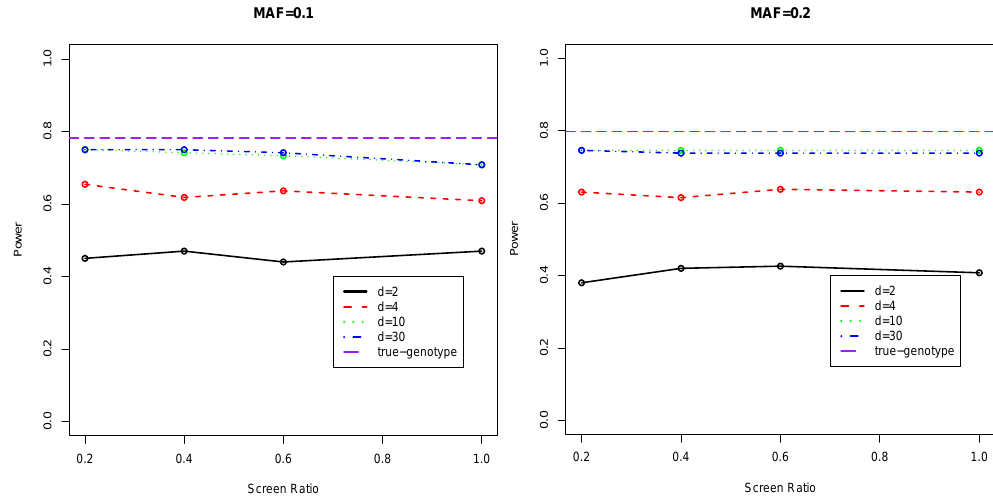
Figure 1. Testing Powers of Binary Phenotype with Covariates Adjusted.